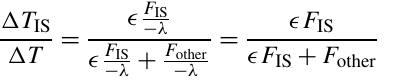
counting for such modifications are scarce (Abe-Ouchi et